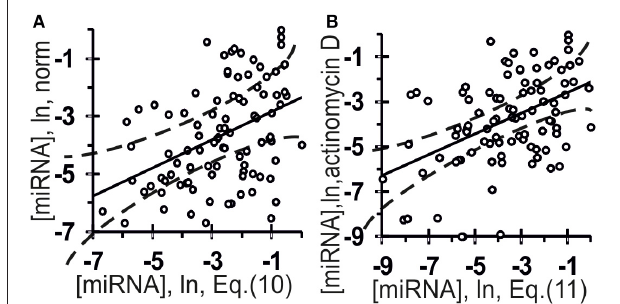
FIGURE 8 | Verification of ill-posed inverse problem solutions (Equation (10) and (11), the x -axis) using the final Equation (5) and independent experimental data (the y- axis) taken from another data source (Bail et al., 2010). The abundance of 96 mature miRNAs in an extract from the human embryonic kidney cell line HEK293T: (A) norm; (B) preincubation for 8h with the transcription inhibitor actinomycin D (Bail et al., 2010). Independentexperimental control data ( y -axes) and in silico estimates and expressed on the same measurement scale [Equation (10) and Equation (11), respectively; x -axes] are statistically significantly correlated ( Table 4 ). Dashed curves and solid lines as in the legend to Figure 3